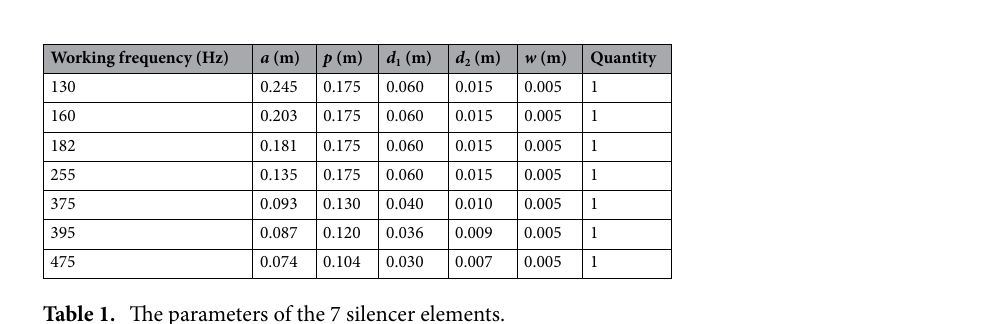
Table 1. The parameters of the 7 silencer